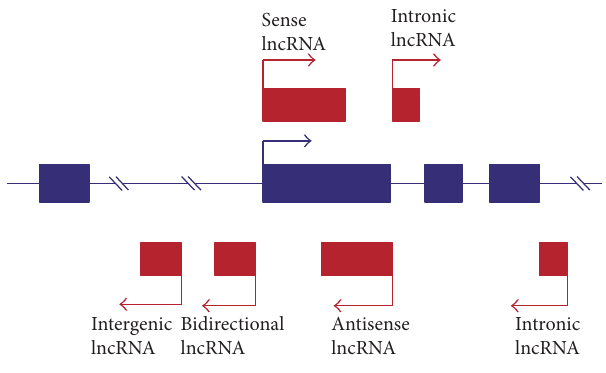
Figure 3: Classification of long noncoding RNAs. lncRNAs (shown as red boxes) may be classified into five categories: sense lncRNAs, antisense lncRNAs, bidirectional lncRNAs (transcribed on the opposite strand within 1kb from the nearest protein-coding gene), intronic lncRNAs, and intergenic lncRNA (transcribed between protein-coding genes, but they are located at least 1kb away from the nearest protein-coding gene) [3]. Detailed descriptions of lncRNA classes are in the main